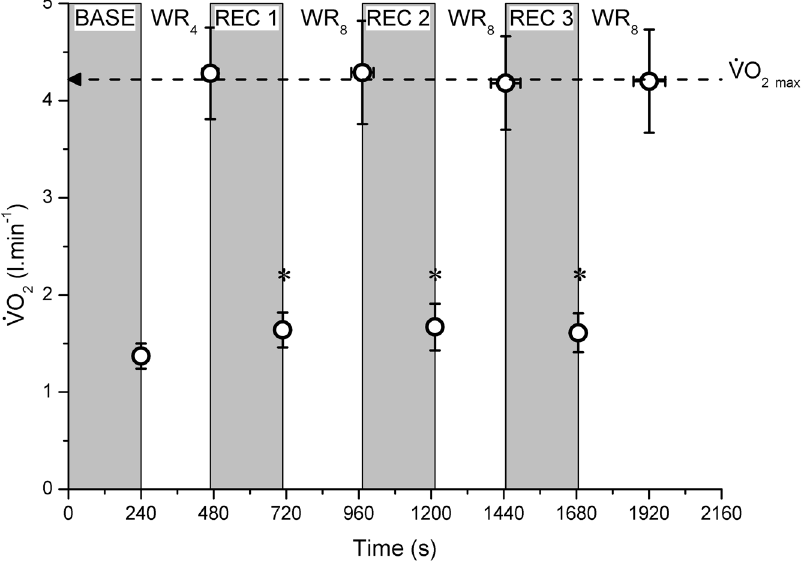
Figure 4. The _ VVO 2 response during the maximal HIIT protocol. Although there was some (insignificant) variability in ON duration at WR 4 (bout 1) and WR 8 (bouts 2, 3 and 4) (horizontal error bars), note the constancy of the _ VVO 2 attained, with this indistinguishable from _ VVO 2 max . Similarly, although _ VVO 2 did not recover to baseline (BASE) following 4 min recovery (REC; P , 0.050, w ), there was no difference in the _ VVO 2 attained in REC following WR 4 (bout 1) or WR 8 (bouts 2 and 3).